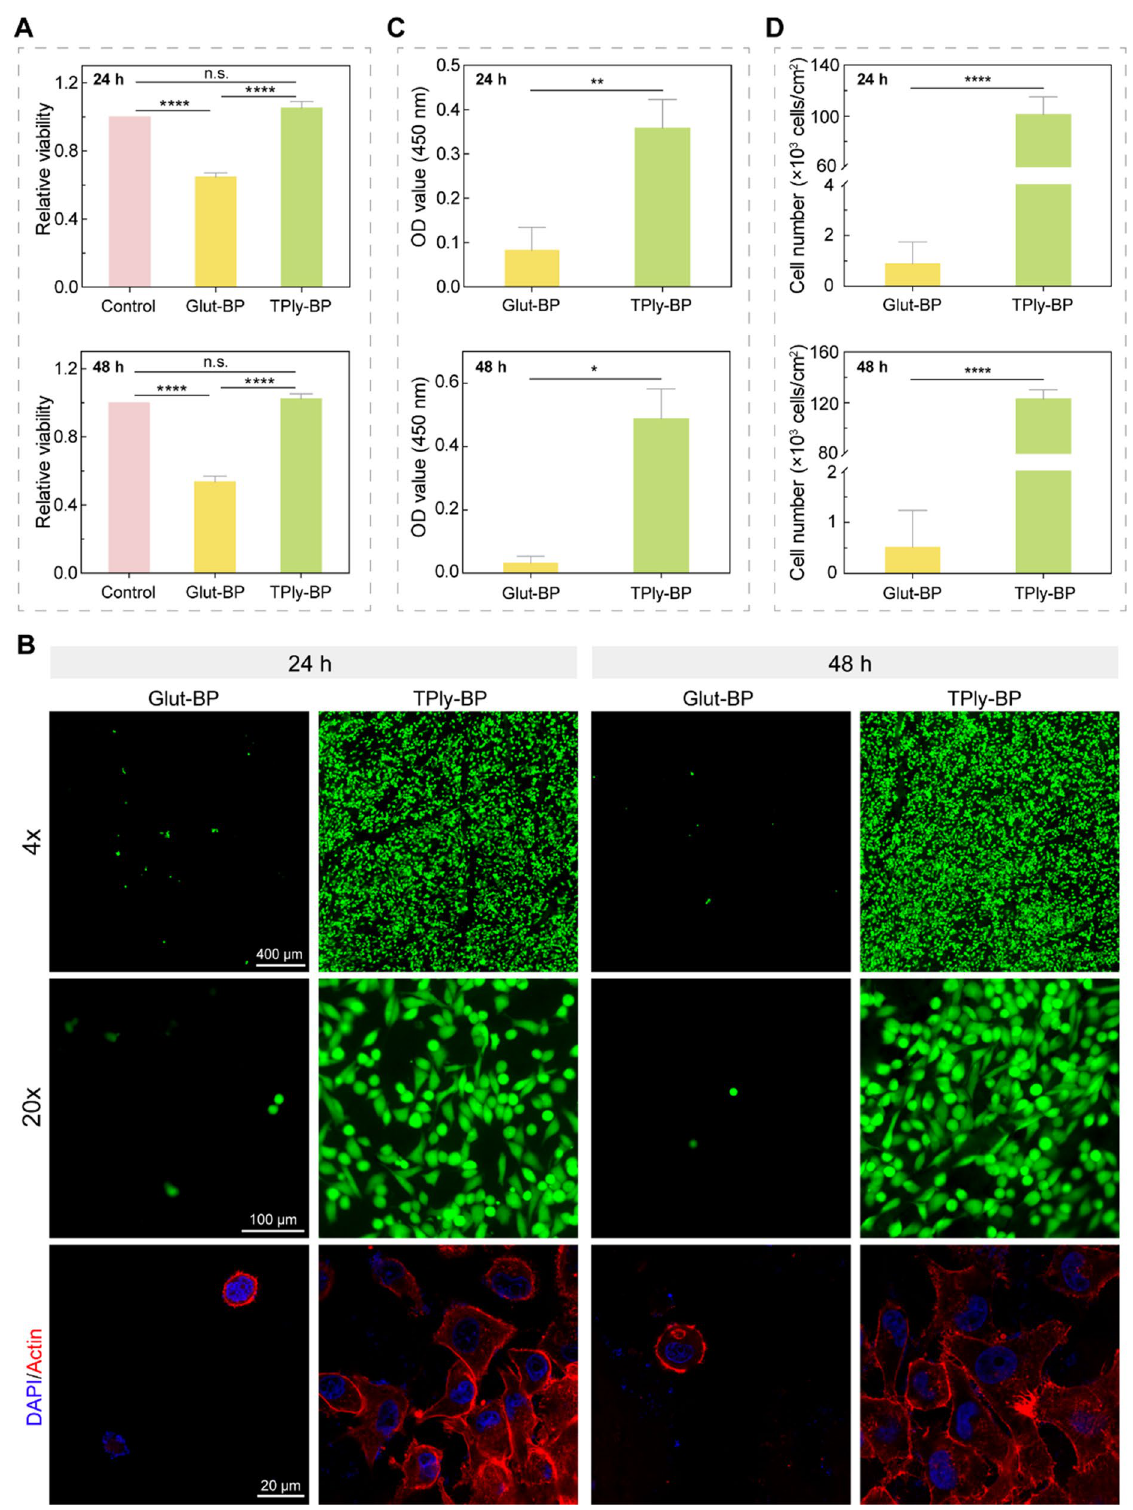
Fig. 6 The cytotoxicity of Glut-BP and TPly-BP. A Relative cell viability of HUVECs after incubation with the extracts of Glut-BP and TPly-BP for 24 and 48 h (n 4). B Fluorescence images of HUVECs cultured on the surface of Glut-BP and TPly-BP stained with Calcein AM (green) and CLSM images = of HUVECs cultured on the surface of Glut-BP and TPly-BP stained with TRITC-phalloidin (red) (actin) and DAPI (blue). C The OD value of HUVECs cultured on the surface of Glut-BP and TPly-BP (n 3). D Cell number statistics of HUVECs cultured on the surface of Glut-BP and TPly-BP (n =